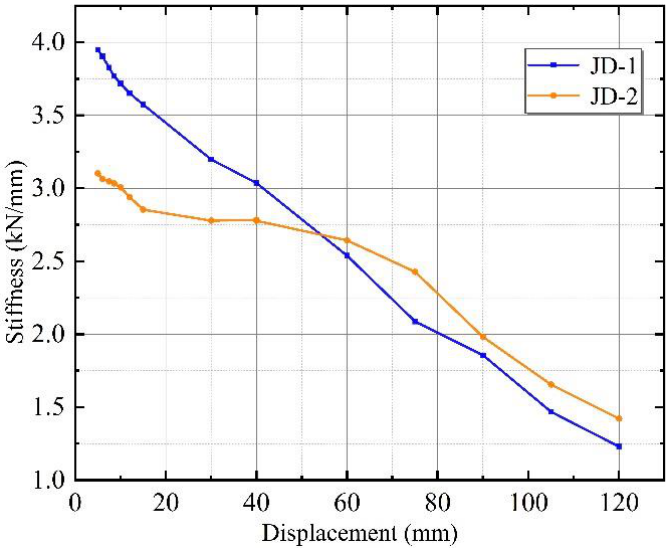
Figure 10. Stiffness degradation of JD-1 and JD-2.